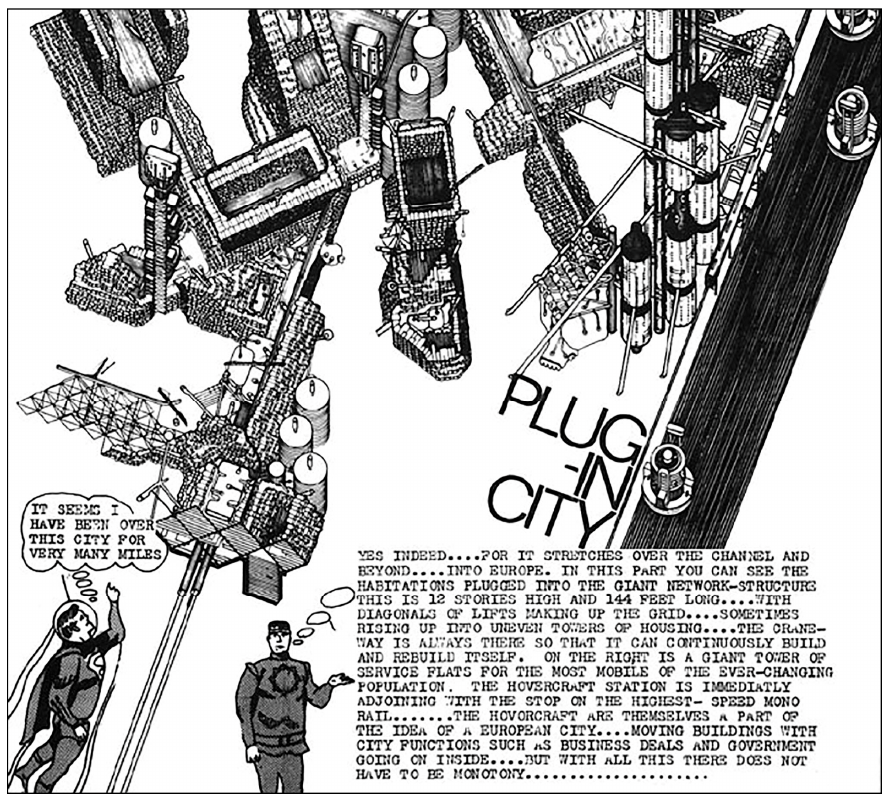
Figure 3. Archigram, Archigram Magazine , 4,